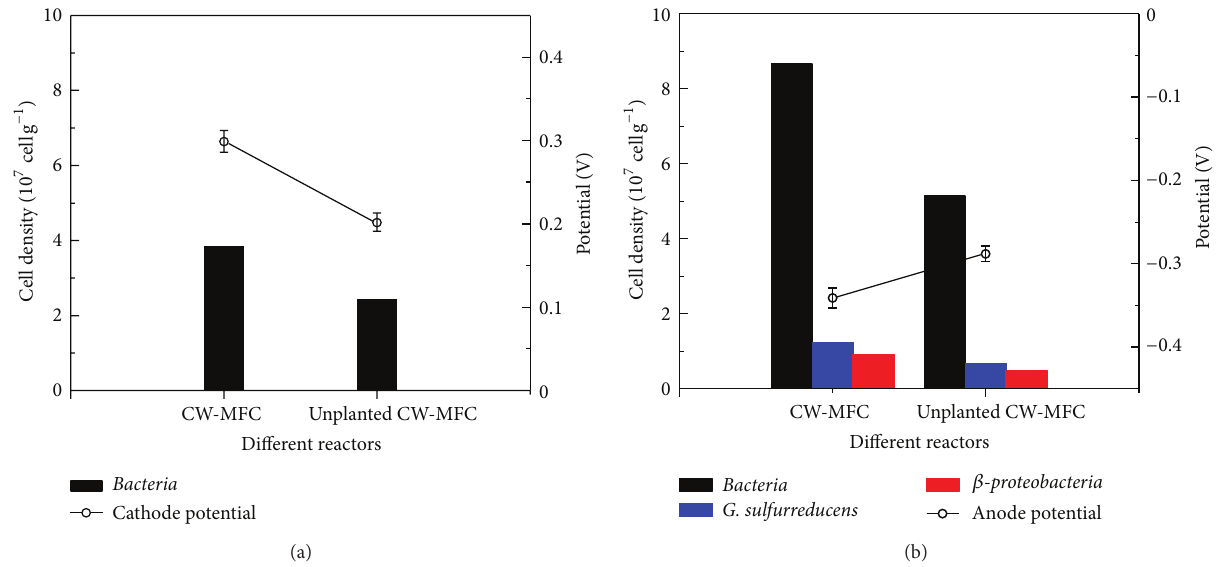
Figure 4: Electrode potential and cell density in electrodes zone for the planted CW-MFC and unplanted CW-MFC: (a) cathode zone and (b) anode zone.